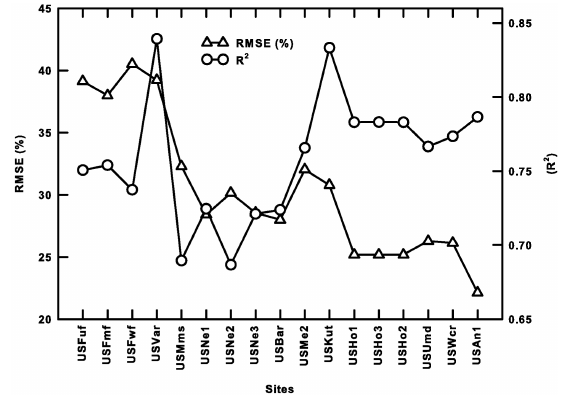
Figure 7. Logistic model performance in terms of RMSE (%) and R 2 over the various sites. The sites are arranged on the x axis fol- lowing an increasing latitudinal gradient from left to